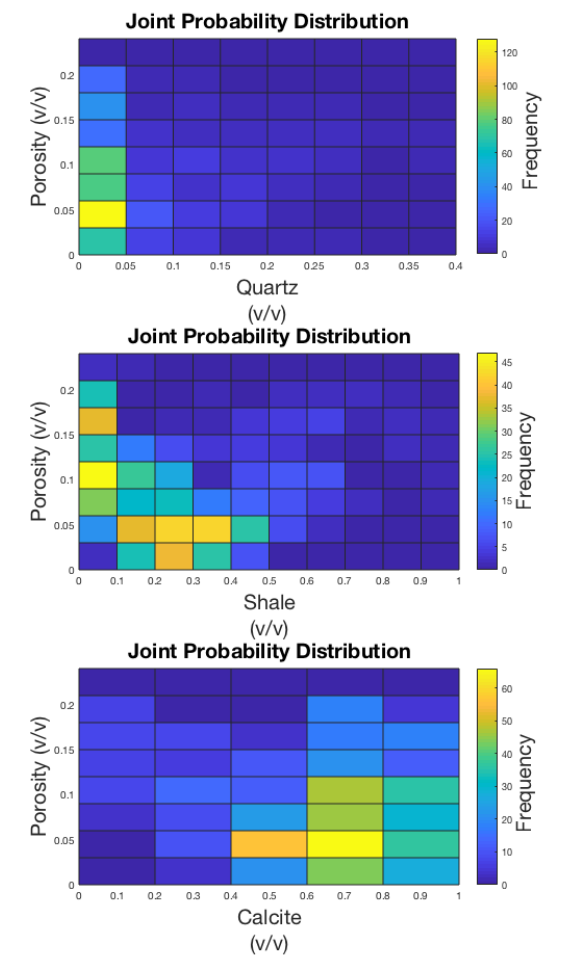
Figure 9. Joint probability distribution of measured porosity and rock constituents for a well in the late Atokan and early Desmoinesian deposits of the Pennsylvanian, Kansas. An increase in calcite can be observed to correspond to a decrease in porosity indicating the diagenetic effect of calcite cementation. Porosity increases with quartz content and decreases with shale